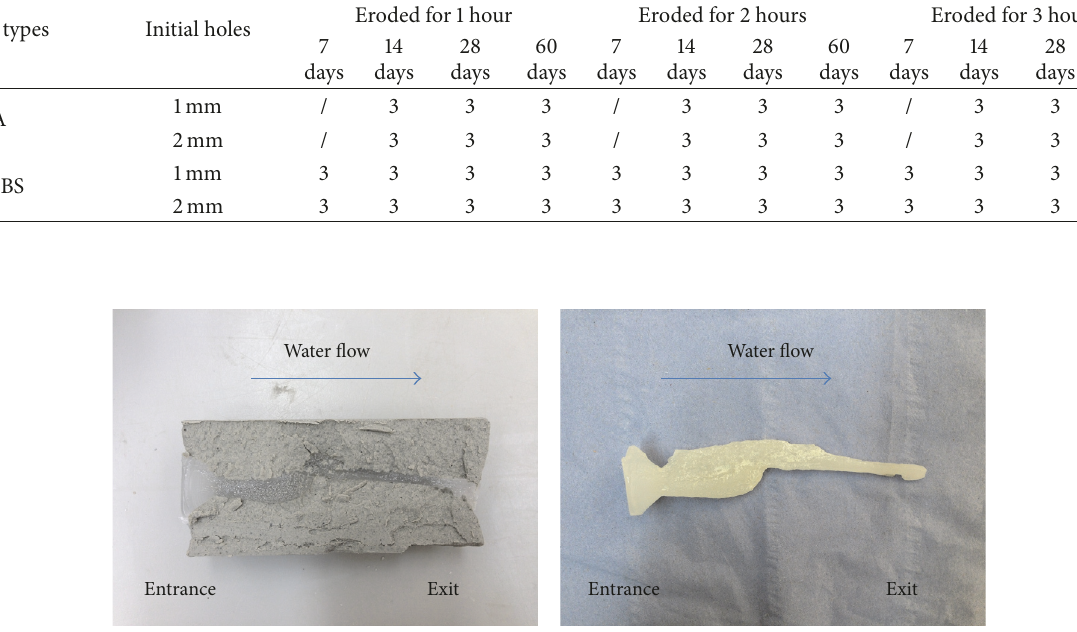
Figure 3: Cross-section showing the cast of an eroded